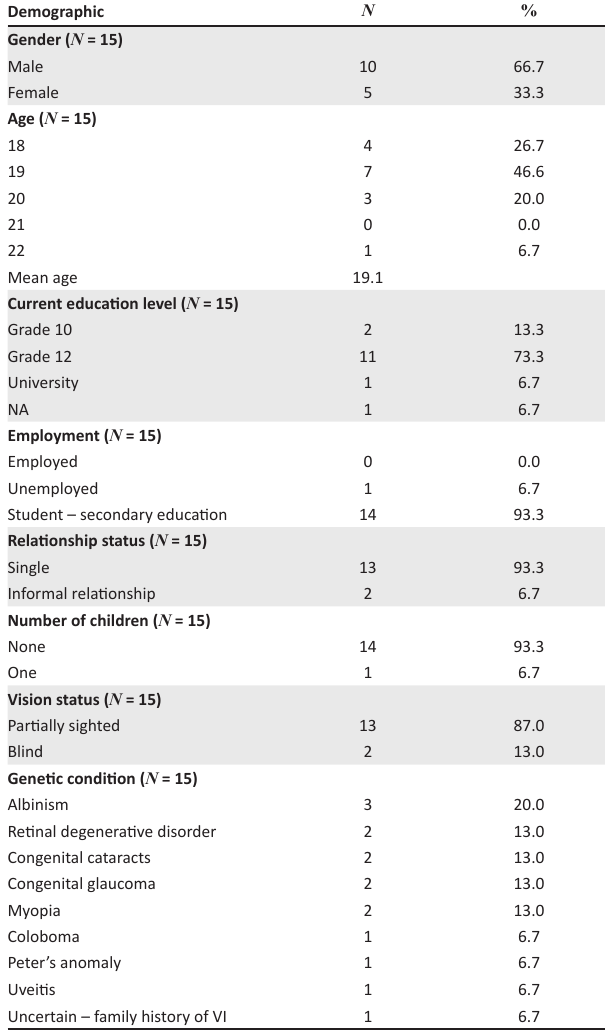
TABLE 2: Participant sociodemographic